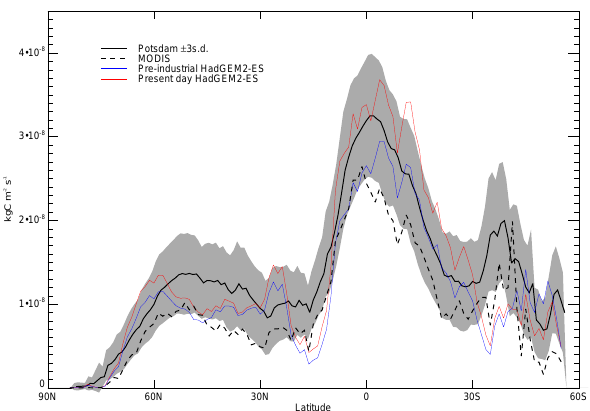
Fig. 18. Zonal mean distribution of NPP from HadGEM2-ES (pre- industrial simulation in blue, present day simulation in red) com- pared with datasets of global NPP from the Potsdam model database (black) with ± 3 standard deviations (shaded) and MODIS (Heinsch et al., 2003; black